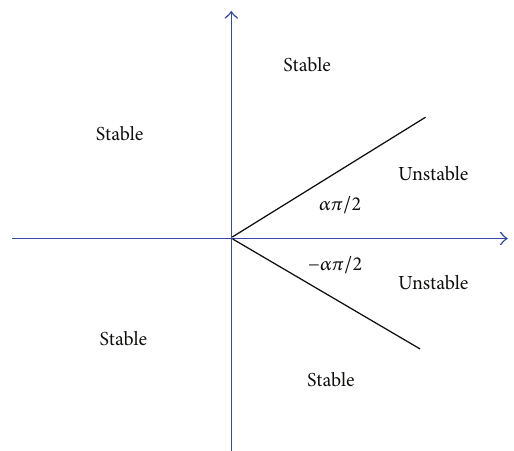
Figure 1: Stability region of linear system (11) with fractional order 0 < 𝛼 < 1